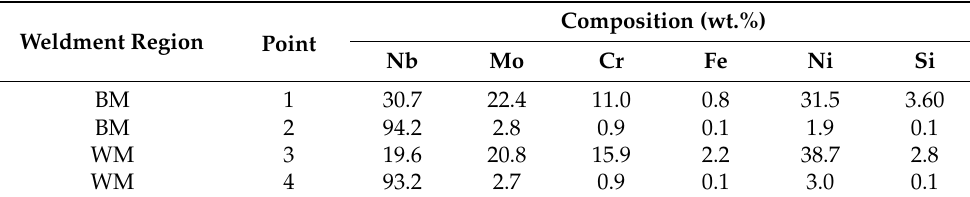
Table 3. EDS chemical composition analyses of the regions highlighted in Figure 4.